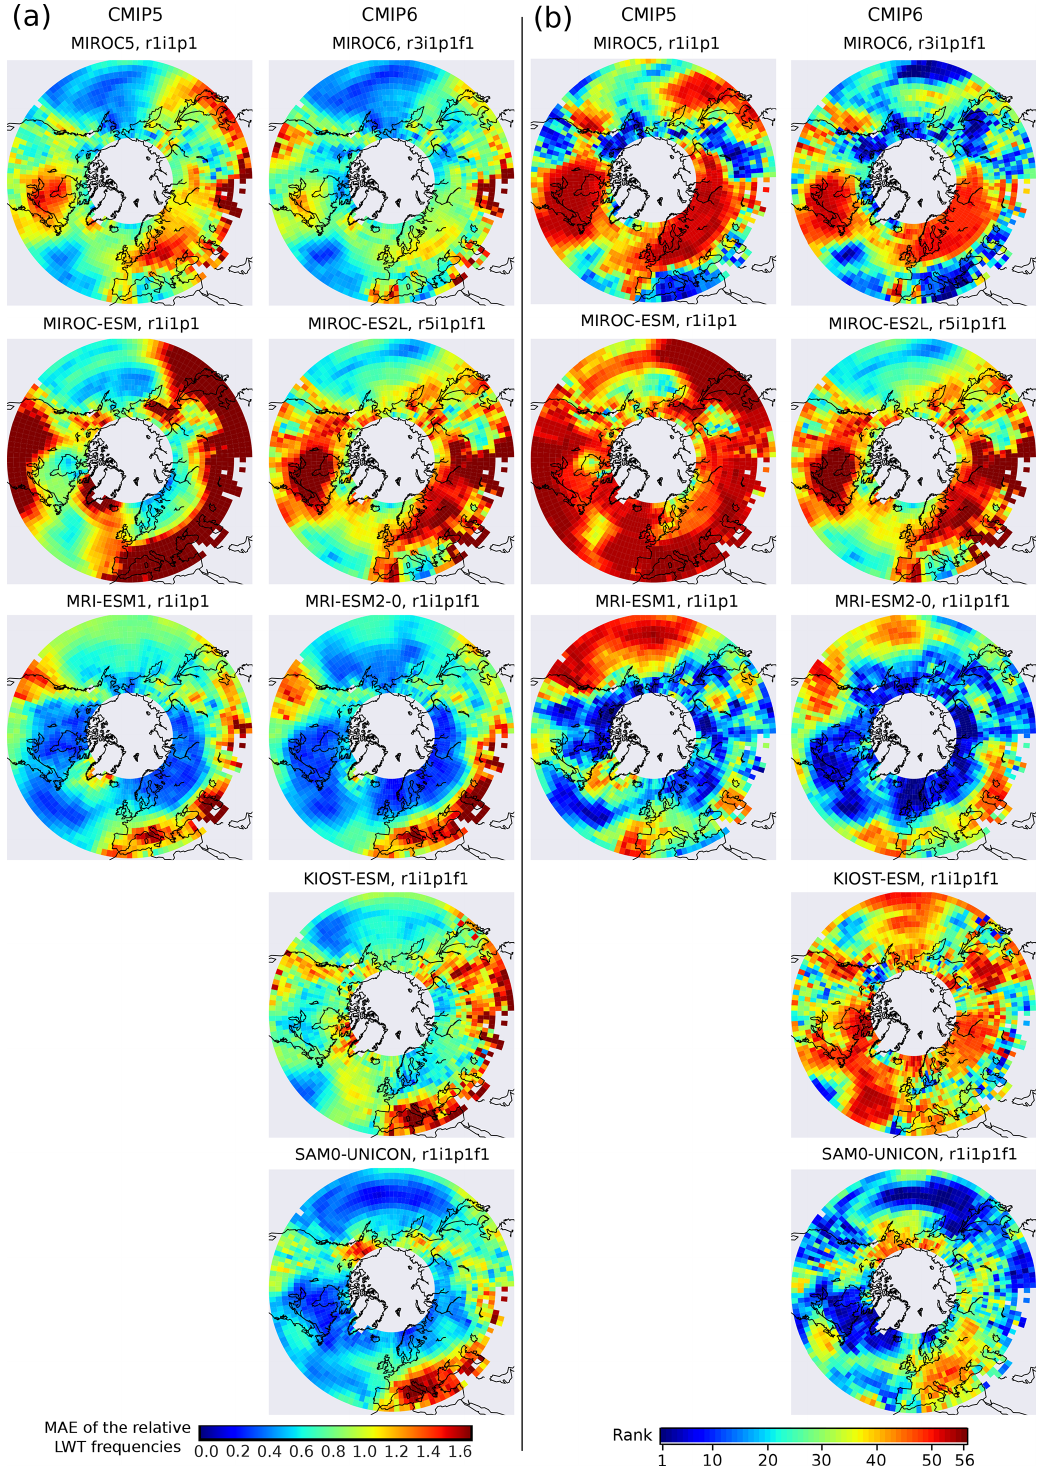
Figure 7. As Fig. 3 but for the MIROC and MRI models, as well as KIOST-ESM and SAM0-UNICON.